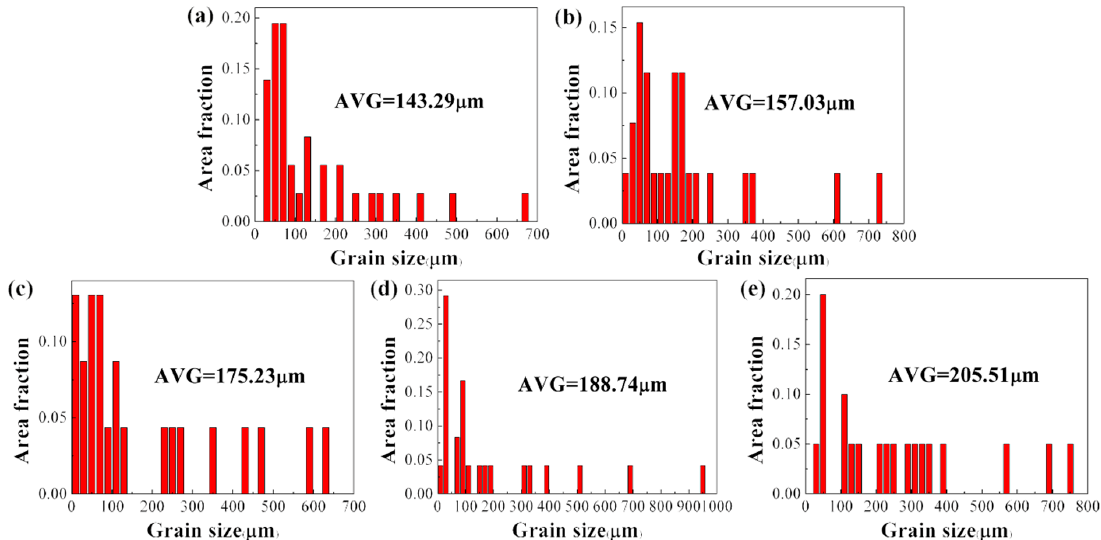
Figure 11. Grain size distributions of specimens: ( a ) as-deposited Ti–26Nb alloy; ( b ) after annealing at 650 °C; ( c ) after annealing at 750 °C; ( d ) after annealing at 850 °C; ( e ) after annealing at 925 °C.